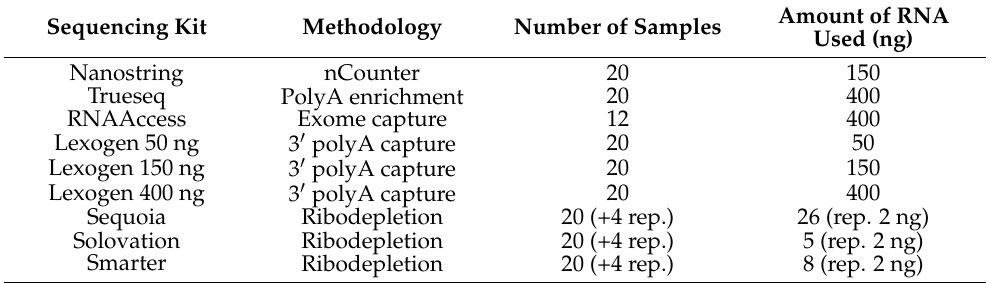
Table 1. Summary of the features of each sequencing kit.